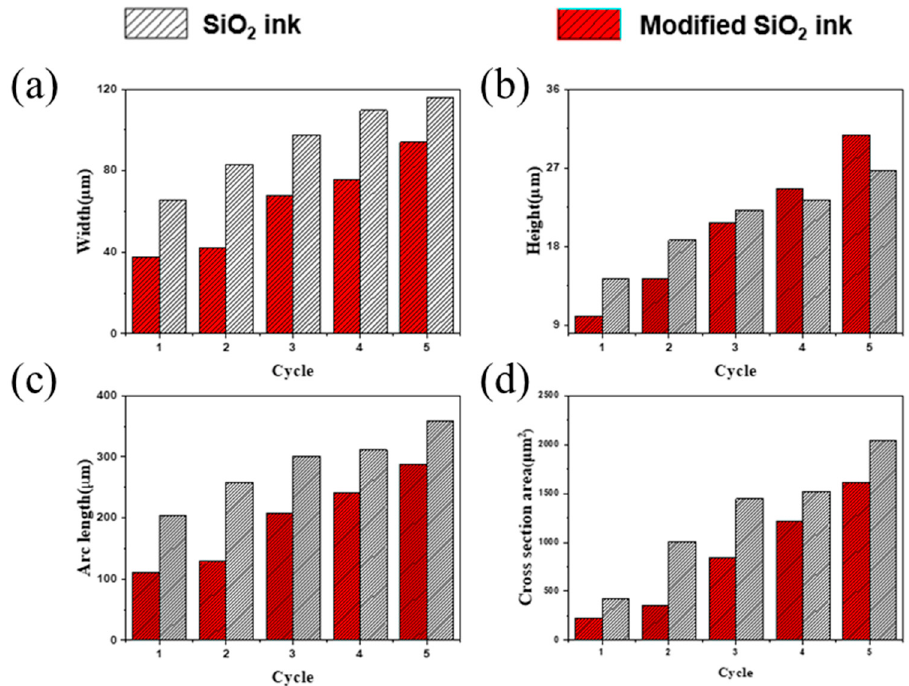
Figure 4. Comparative analysis results of ( a ) width, ( b ) height, ( c ) arc length, ( d ) cross-section area of ink-jet 3D printed dot using photo-curable nano SiO 2 ink and modified nano SiO 2 ink.